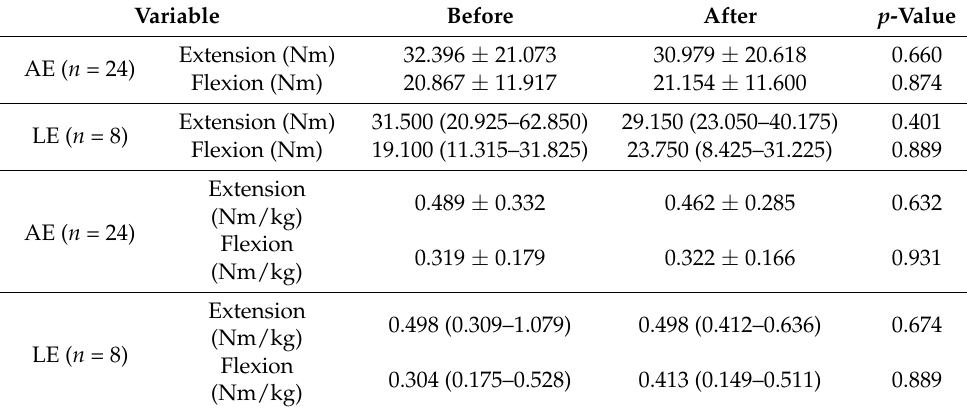
Table 3. Comparison of the knee joint muscle strengths in the AE and LE groups. (All the patients who performed this test underwent bilateral